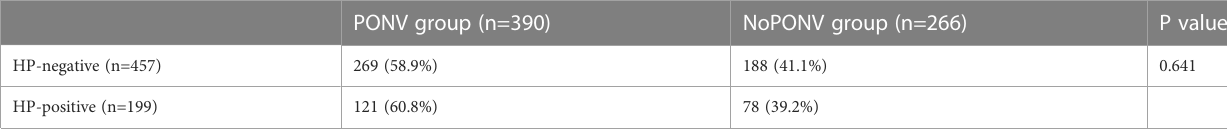
TABLE 2 Occurrence of PONV in 656 LSG patients with HP-positive and